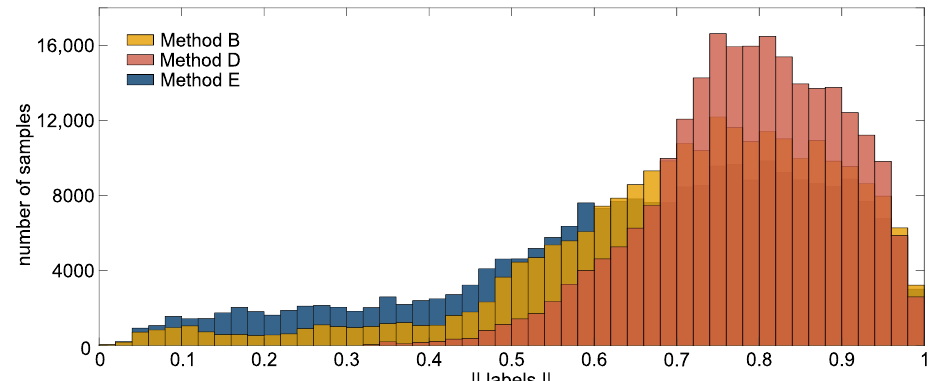
Figure 8. Histogram of the continuous labels. Shown is a histogram of the generated labels of the methods using continuous labels B, D, and E. The data includes the labels between 0 and 1 of all subjects and directions (0 is